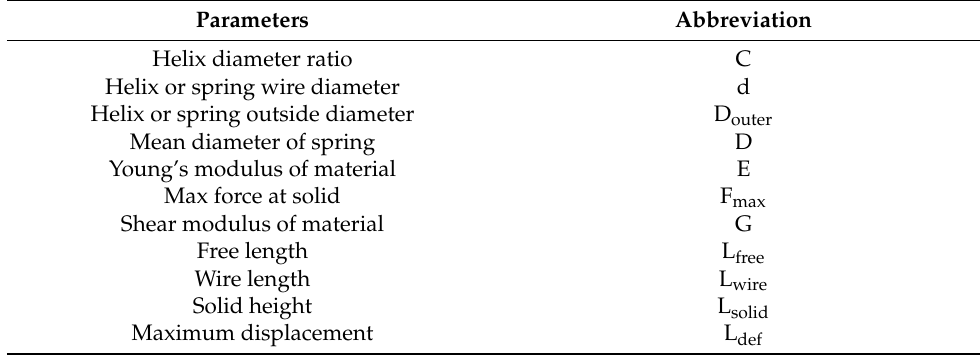
Table A1. Parameters for spring engineering variables utilised in design equations. (Source: